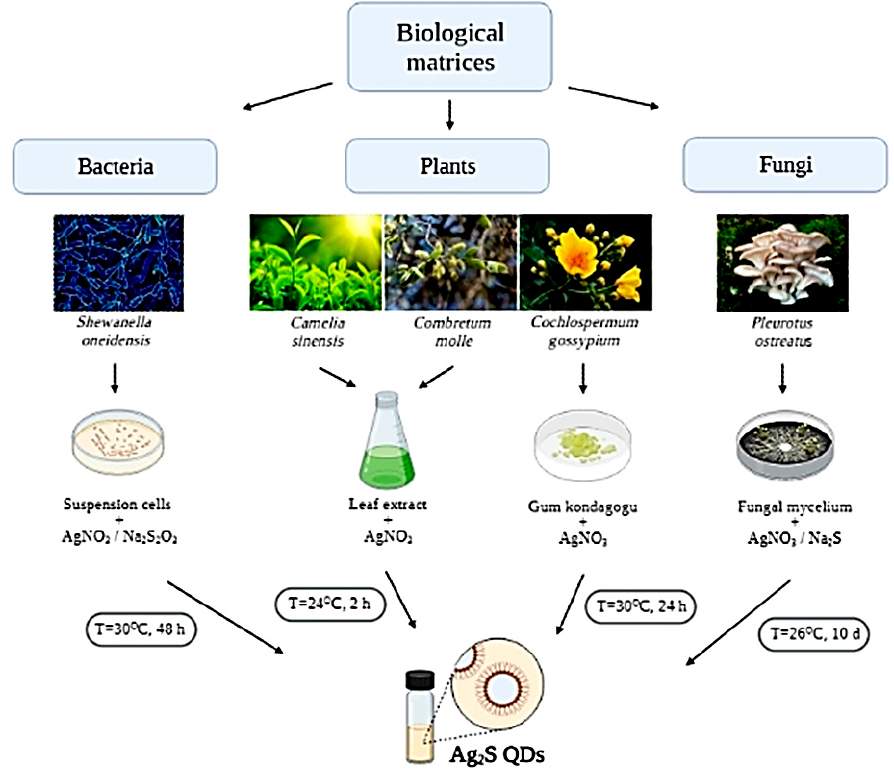
Figure 3. Synthesis of Ag 2 S QDs using different biological matrices .